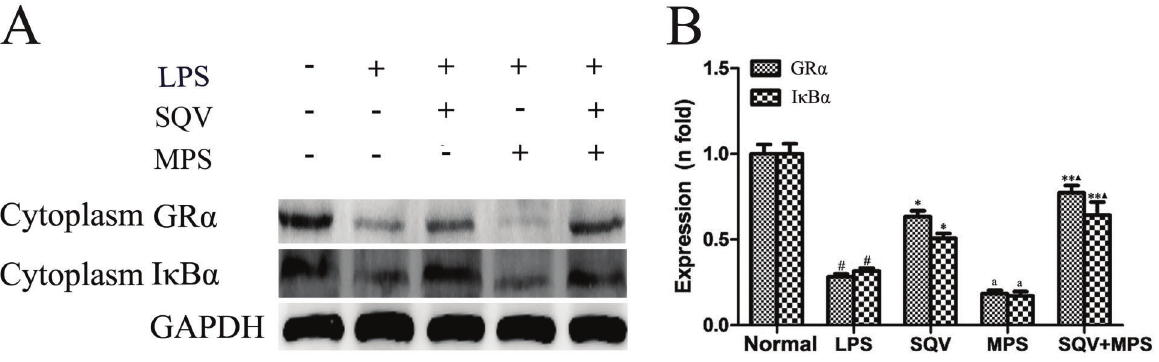
Figure 3. Effects of saquinavir (SQV) on glucocorticoid receptor alpha (GR a ) and I k B a expression in lipopolysaccharide (LPS)-stimulated human pulmonary microvascular endothelial cells by western blotting. MPS: methylprednisolone. Data are reported as means ± SD